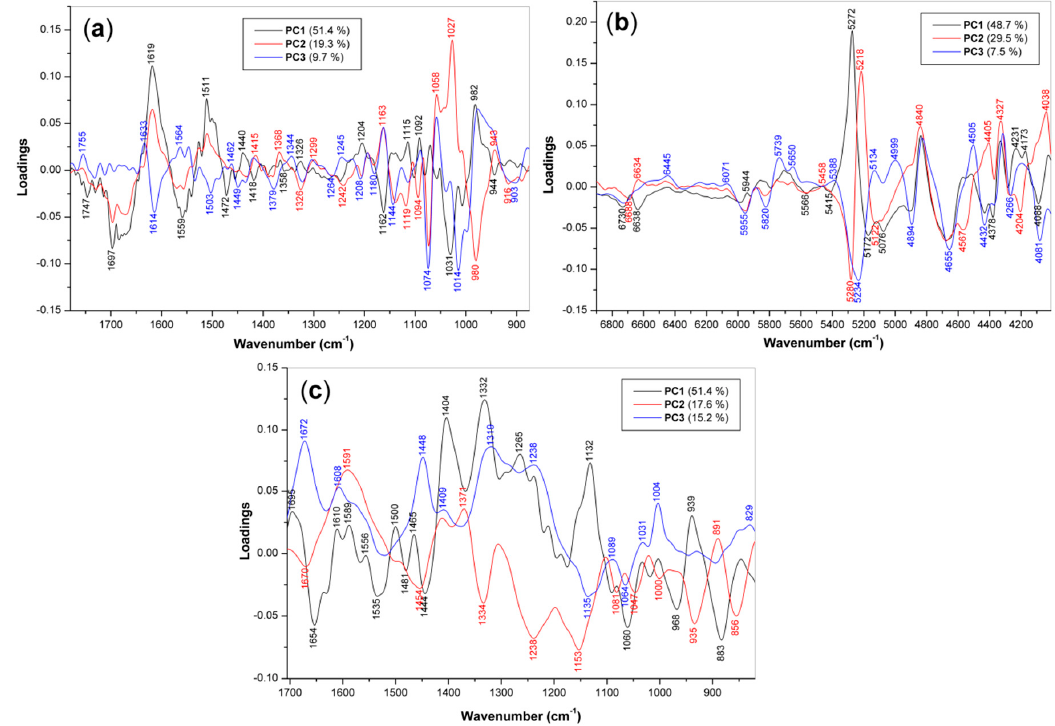
Figure 2. PCA loadings of the first three PCs for the spectroscopic data: ( a ) FT MIR, ( b ) FT NIR and ( c ) FT Raman.